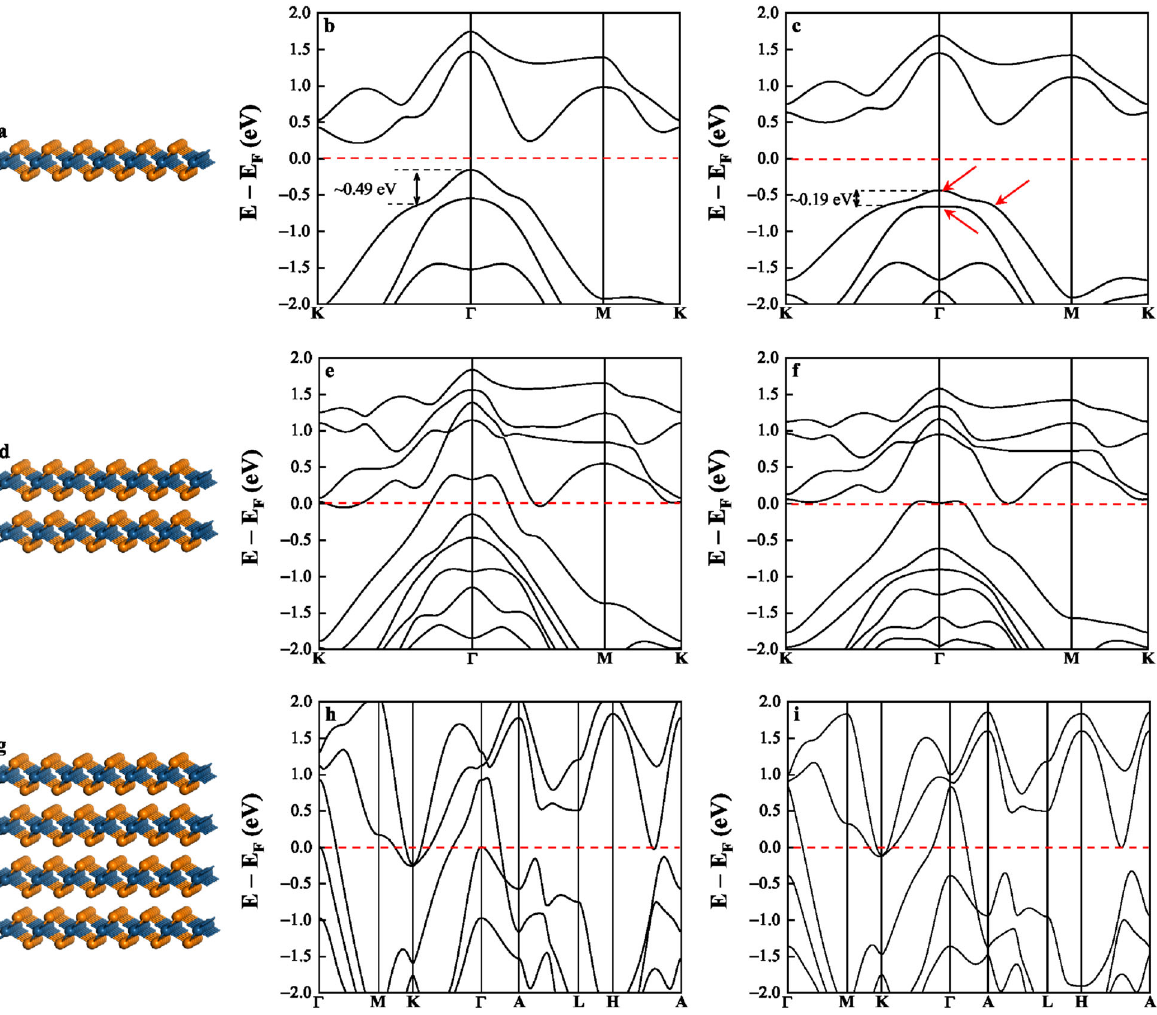
Fig. 4 Atomic and electronic structure of pristine PtTe 2 . Side view schematic (left column: a , d , and g ), and band structure considering GGA + SOC (middle column: b , e , and h ) and GGA-1/2 + SOC (right column: c , f , and i ), of monolayer PtTe 2 (top row), bilayer PtTe 2 (middle row), and bulk PtTe 2 (bottom row). Modi fi cation of the band structure is pronounced when the GGA-1/2 technique is employed. Transition from semiconducting- to-semimetallic is evident by the closure of bandgap as the fi lm thickness increases. Energies are referenced to the Fermi